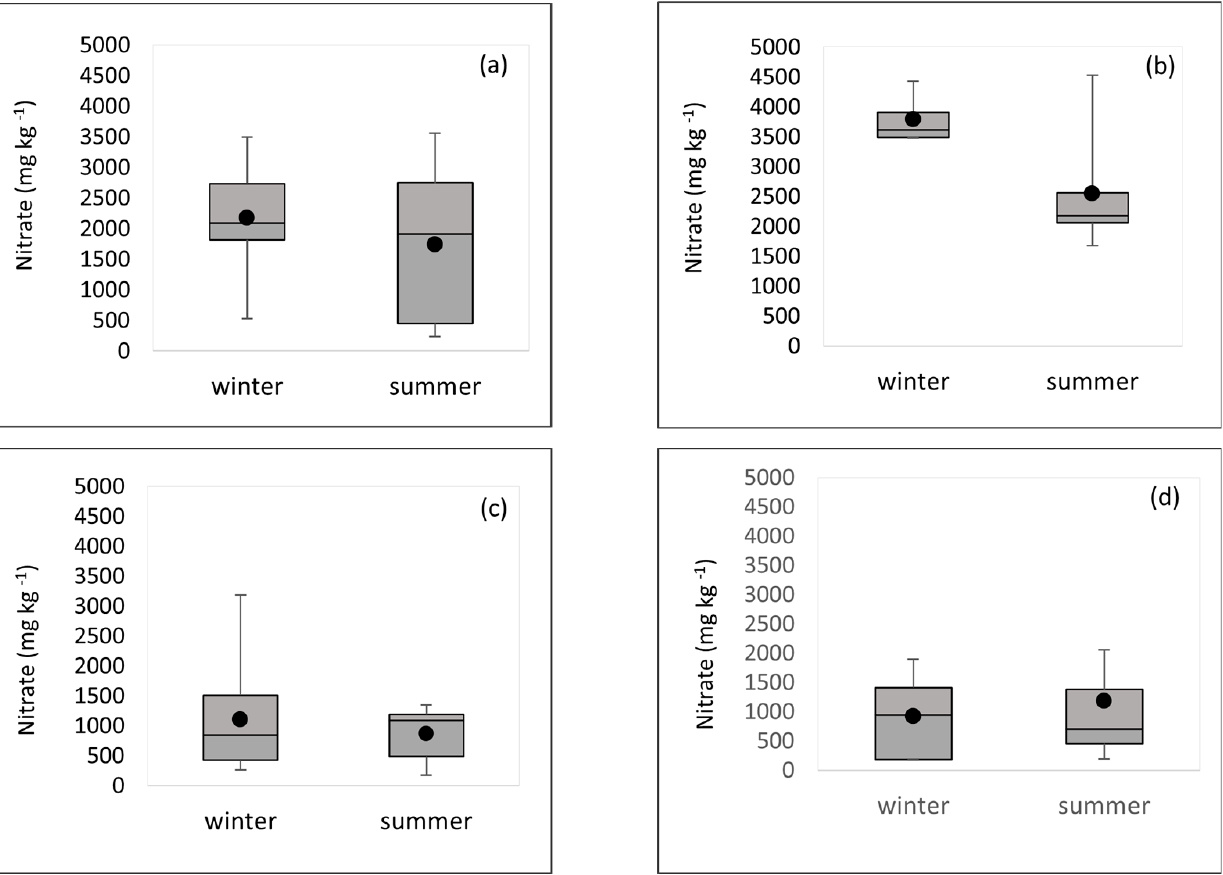
Figure 4. Distribution of the nitrate concentrations depending on the season: ( a ) Swiss chard; ( b ) rucola; ( c ) lettuce; ( d ) spinach.